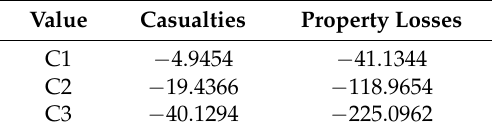
Table 4. Evaluation values of emergency loss levels.